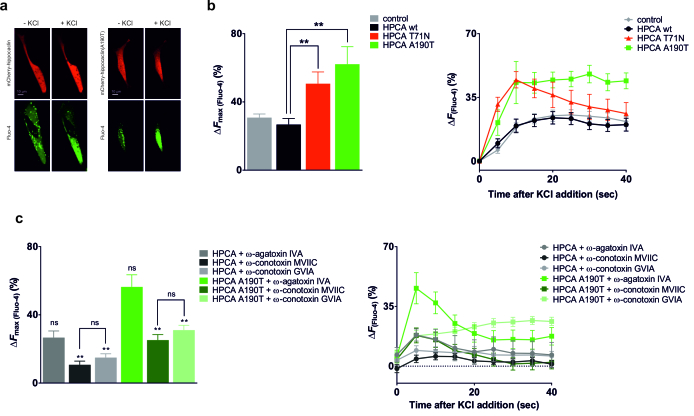
Dystonia-causing hippocalcin mutants increase depolarisation-induced calcium influx through N-type voltage-gated calcium channels. Differentiated SH-SY5Y cells transfected with hippocalcin-mCherry constructs were loaded with Fluo-4 to monitor calcium concentration changes. After KCl depolarisation, live cells were imaged on a spinning-disk confocal microscope. (A) Representative microscopy images of KCl-stimulated cells transfected with hippocalcin or hippocalcin(A190T), showing intracellular calcium increase upon depolarisation. (B) Maximum intracellular calcium increase and time course after KCl stimulation, showing that hippocalcin(T71N) and hippocalcin(A190T) increases calcium entry in response to depolarisation. Transfection control (n = 15), hippocalcin wild-type (n = 13), hippocalcin(T71N) (n = 15) and hippocalcin(A190T) (n = 14). Data are expressed as mean ± SEM. Statistical analysis was performed using hippocalcin as control (Student t-test). (C) Maximum intracellular calcium increase and time course after KCl stimulation, showing that calcium entry in response to depolarisation is determined by N-type voltage-gated calcium channels. Hippocalcin wild-type + 0.4 μM ω-agatoxin IVA (n = 9), hippocalcin wild-type + 10 μM ω-conotoxin MVIIC (n = 10), hippocalcin wild-type + 1 μM ω-conotoxin GVIA (n = 13), hippocalcin(A190T) + 0.4 μM ω-agatoxin IVA (n = 14), hippocalcin(A190T) + 10 μM ω-conotoxin MVIIC (n = 15), hippocalcin(A190T) + 1 μM ω-conotoxin GVIA (n = 22). Data are expressed as mean ± SEM. Statistical analysis was performed using untreated hippocalcin or untreated hippocalcin(A190T) as controls (Student t-test).